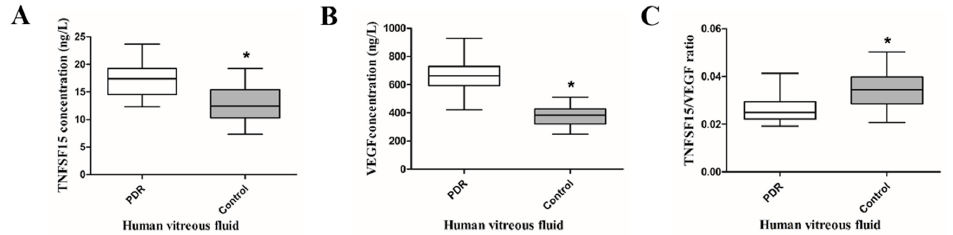
Figure 1. Comparison of vitreous TNFSF15 and VEGF concentrations in PDR patients and controls. * p = 0.000, significantly different from the PDR group ( A ) Vitreous TNFSF15 concentrations were significantly higher in PDR patients than in controls (* p = 0.000); ( B ) Vitreous VEGF concentrations